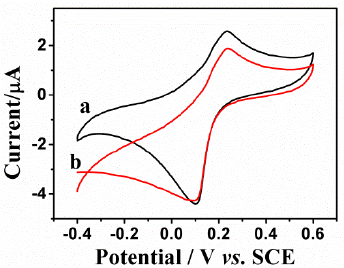
Figure 6. CVs obtained at the GOD–BSA/Fe 3 O 4 -PB/GCE in 0.01 M PBS (pH 6.0) containing 0.1 M KCl in the absence ( a ) and presence ( b ) of 1 mM glucose with the scan rate of 50 mV s − 1 .